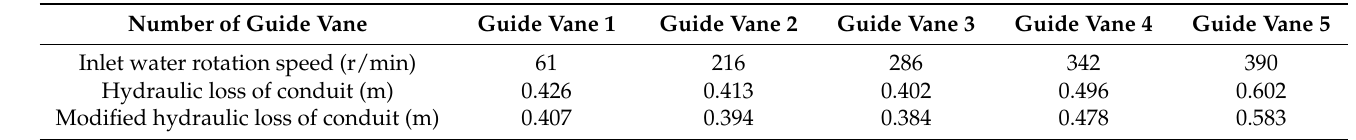
Table 3. Inlet water rotation speeds on the cross-sections of different guide vanes and corresponding hydraulic loss in outlet conduit under design